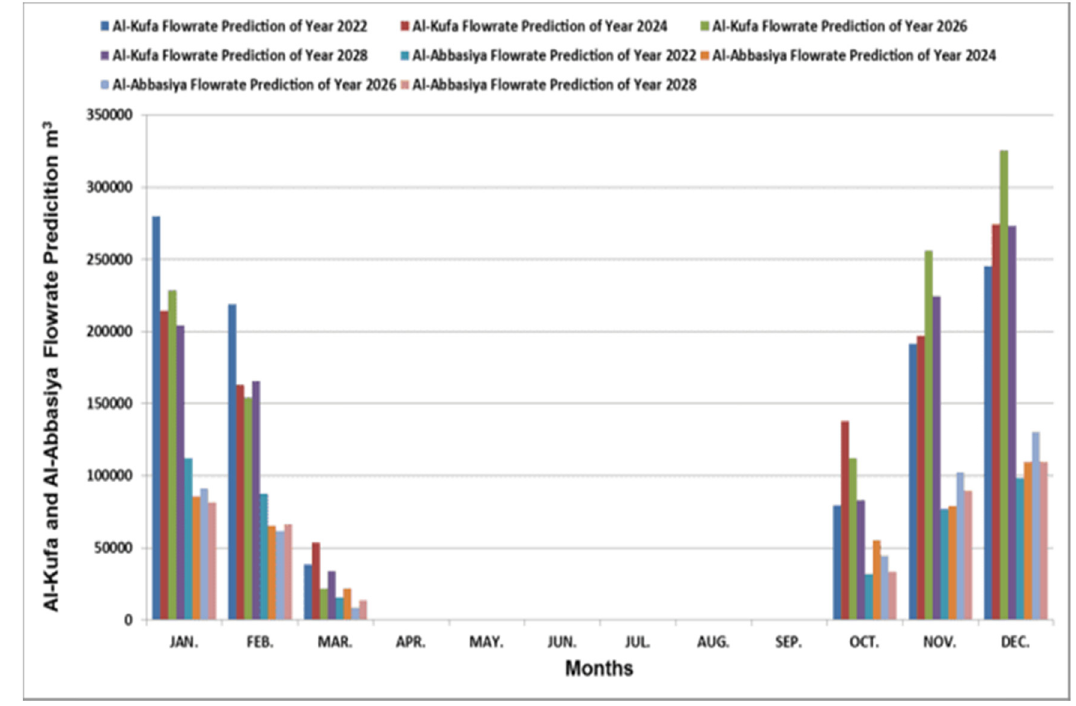
Figure 8: Future predicted fl owrates of Al - Kufa and Al - Abbasiya Rivers ( branches of the Euphrates River )